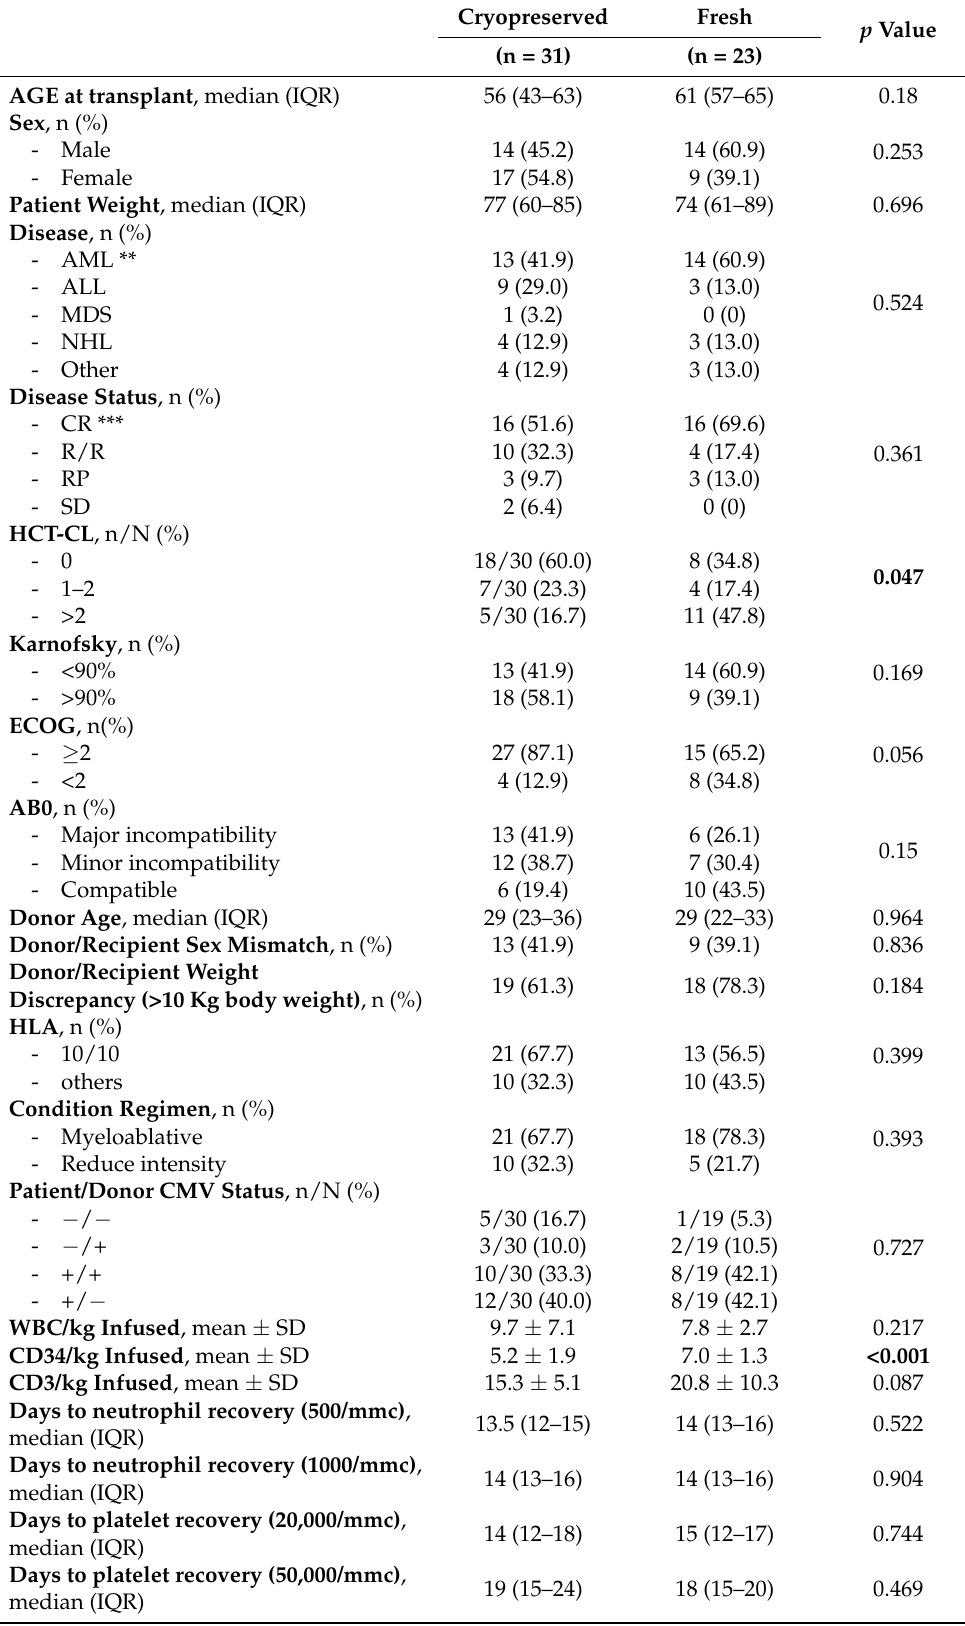
Table 1. Patients’